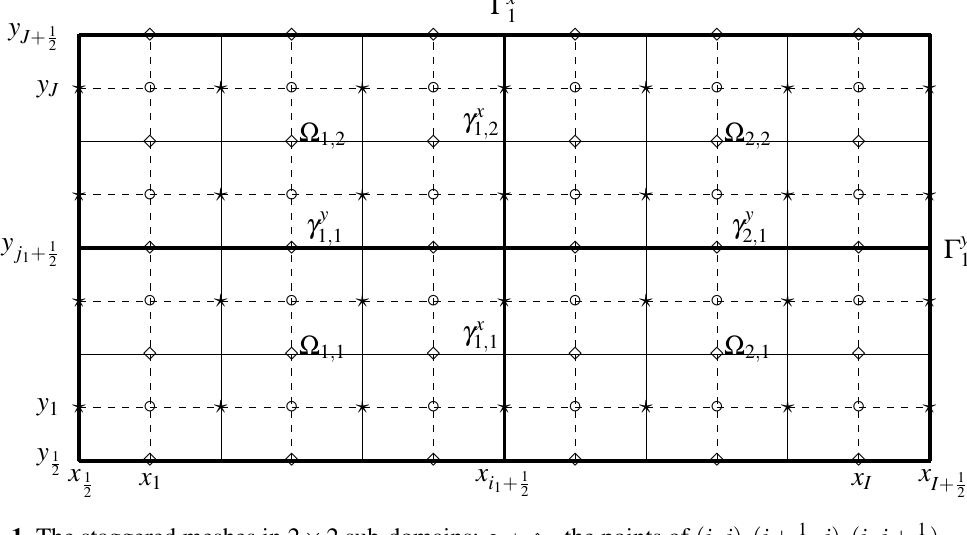
Fig. 1 The staggered meshes in 2 × 2 sub-domains: ◦ ,(cid:63), (cid:5) - the points of ( i , j ) , ( i + 1 solution. The line Γ x is the interface of Ω 1 , q and Ω 2 , q , q = 1 , 2, where i 1 denotes the mesh point index : x = x i 1 + 1 1 2 of interface location of Γ x along x − direction. The line Γ y 1 Ω p , 2 , p = 1 , 2, and j 1 denotes the mesh point index of interface location of Γ y